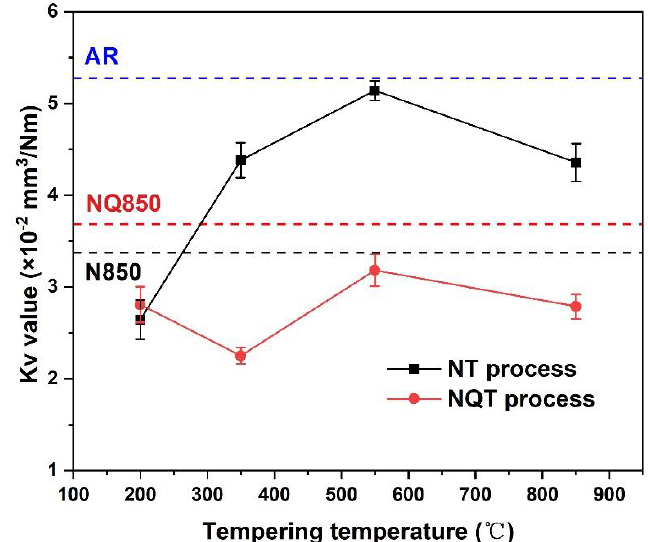
ff erent tempering v value under di